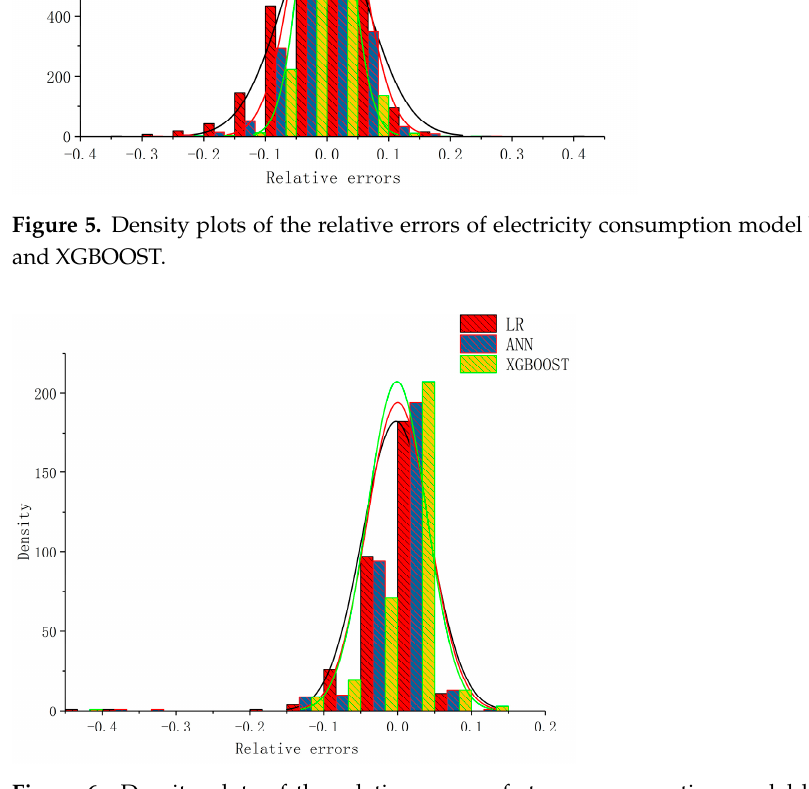
Figure 6. Density plots of the relative errors of steam consumption model built by LR, ANN and XGBOOST. Table 6. The RMSE and MAPE of the three electricity consumption models.